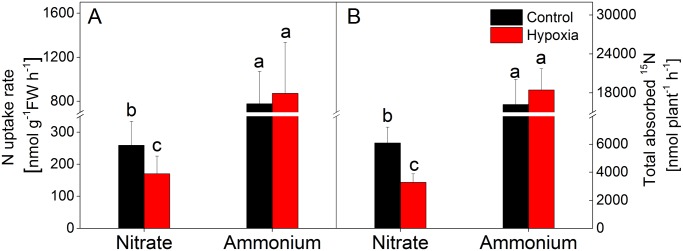
Effects of hypoxia on 15NO3
- and 15NH4
+ uptake rate.After a treatment period of 14 days, the poplar seedlings were supplied with either 14NH4Cl and K15NO3 or 15NH4Cl and K14NO3 at final N concentrations of 2.0 mM and incubated for 2 h. Trees were then harvested, 15N contents analyzed in dried tissues and N uptake rates calculated as described in materials and methods. Data shown are means ± SD of 10–12 biological replicates. The differences between hypoxic and normoxic control plants were calculated by LSD under ANOVA. Different lower case letters indicate statistical differences at p<0.05 between control and hypoxia treated poplar trees supplied with 15NO3
- or 15NH4
+.